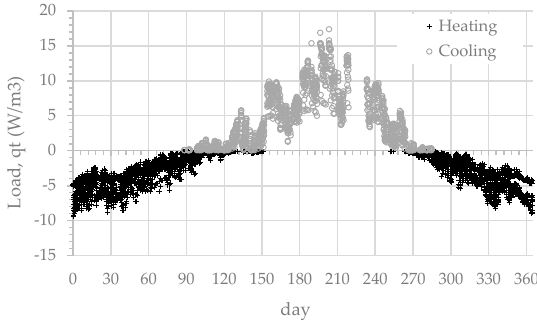
Figure 2. Heating and cooling loads per unit volume ( q t , W / m 3 ) of reference building space for the year 2015.